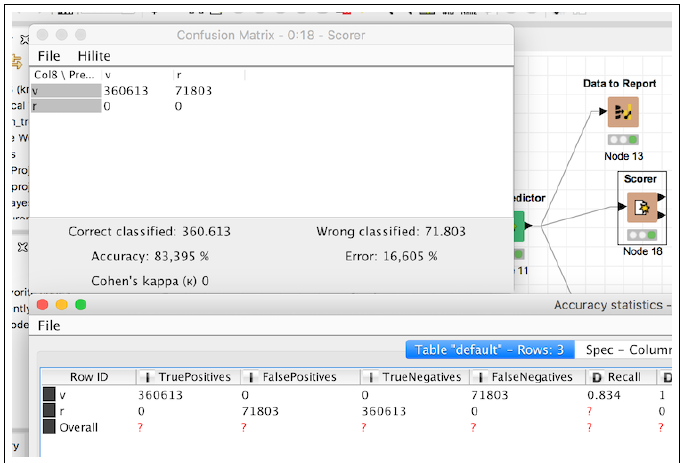
Fig. 9. Confusion matrix using S3 model and the decision tree over D h